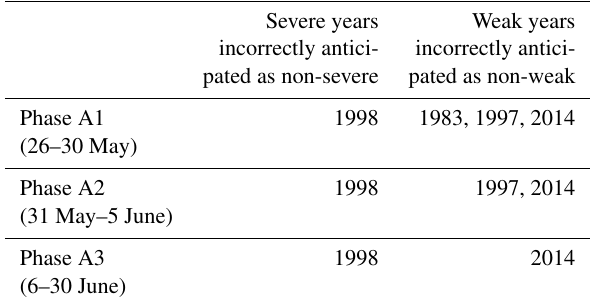
Table 3. As in Table 1 but for the model with one covariate. Severe years Weak years incorrectly antici- incorrectly antici- pated as non-severe pated as